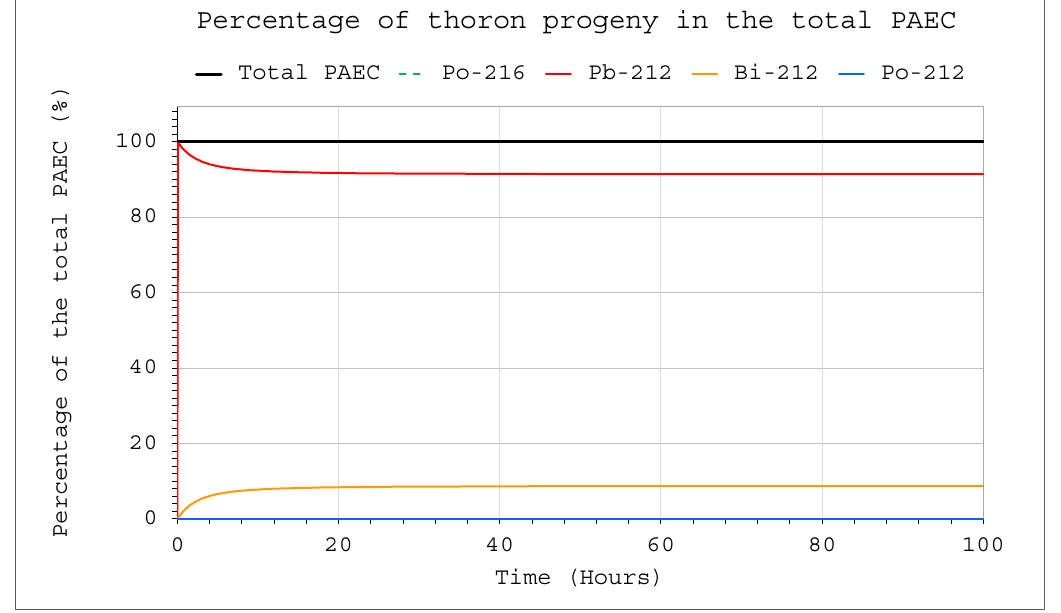
Figure 8. Percentage of the individual thoron progeny in the total PAEC inside the system for the following conditions: inflow of thoron throughout the analyzed period at a rate of E 1 = 1 Bq/s, V = 20 m 3 , C oi = 0. No operating filtration system was operating inside.